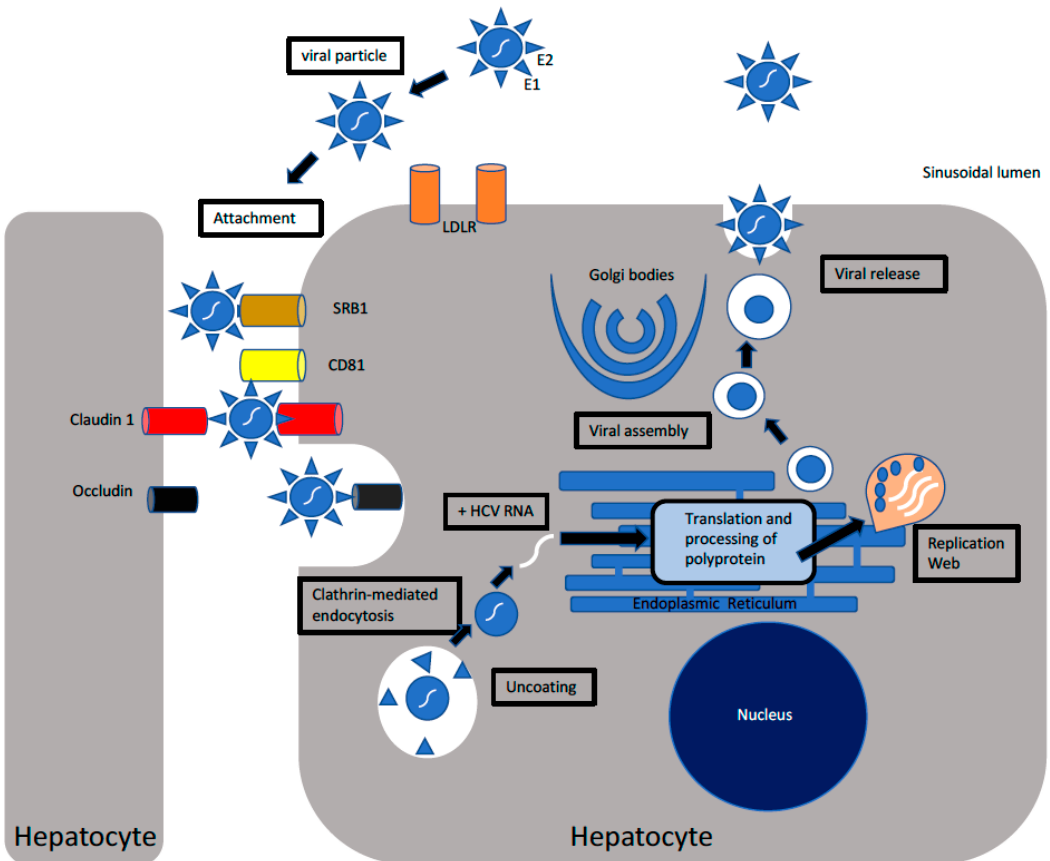
Figure 1. The replication of hepatitis C (HCV): The virus via its envelope glycoproteins attach to host cellular receptors such as claudin-1, epidermal growth factor receptor (EGFR), scavenger